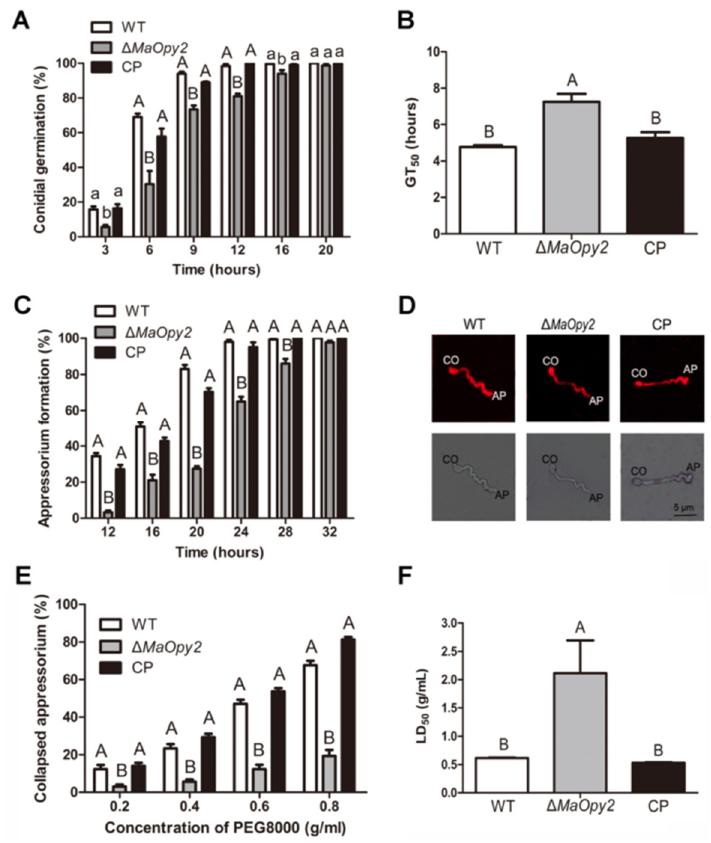
Figure 5. Appressorium assays. ( A ) Germination of conidia on the locust wings of fungal strains. ( B ) The GT 50 s of different strains on locust wings. ( C ) Appressorium formation of different fungal strains. ( D ) Lipid distribution in appressoria stained with Nile red. ( E ) Collapsed appressorium treated with different concentrations of PEG 8000. ( F ) LT 50 s of PEG 8000 for fungal strains. A & B and a & b presented the significant difference at p < 0.01 and p < 0.05,